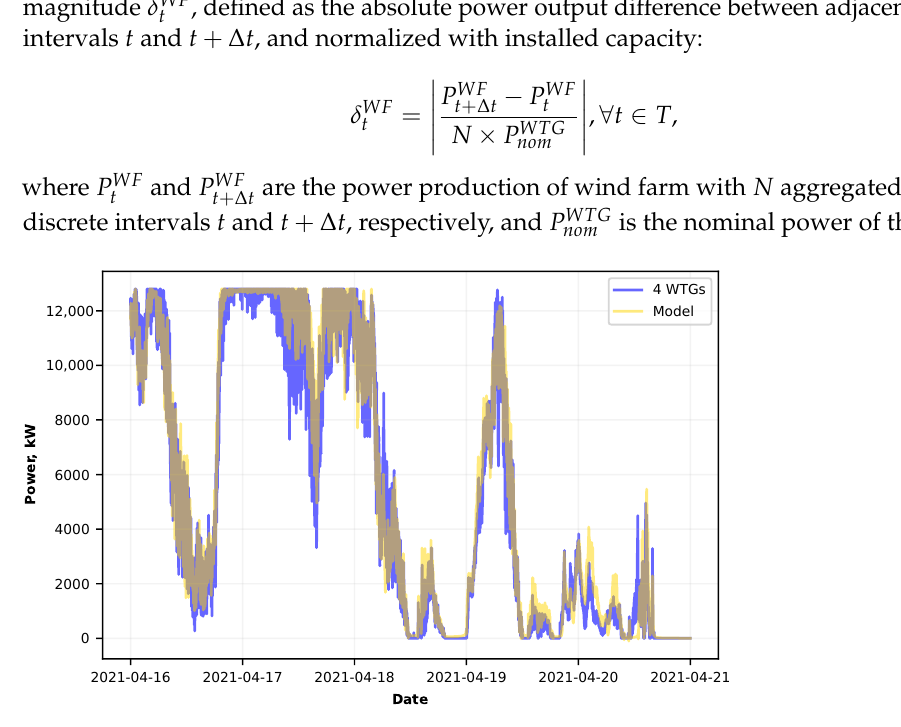
Figure 7. Wind farm power production with four 3200 kW WTGs and the proposed model power production during a period of 5 days. The shaded area represents periods when actual and modelled power